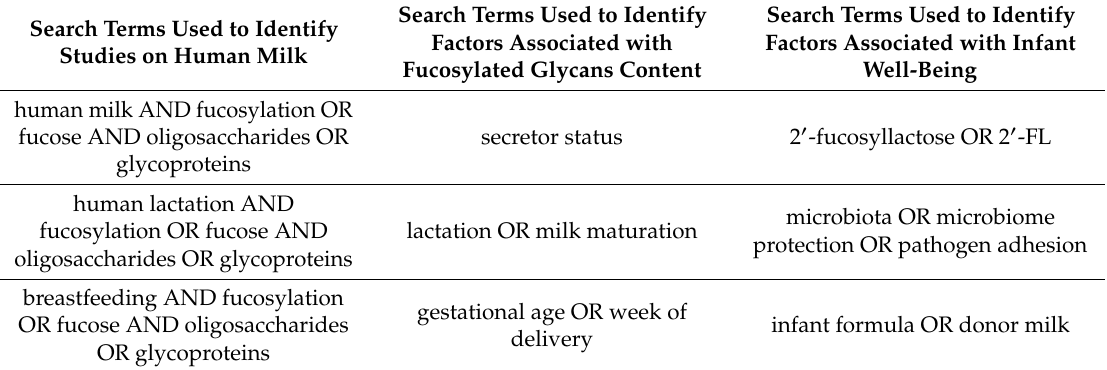
Table 1. Search strategies and terms used to identify studies for this